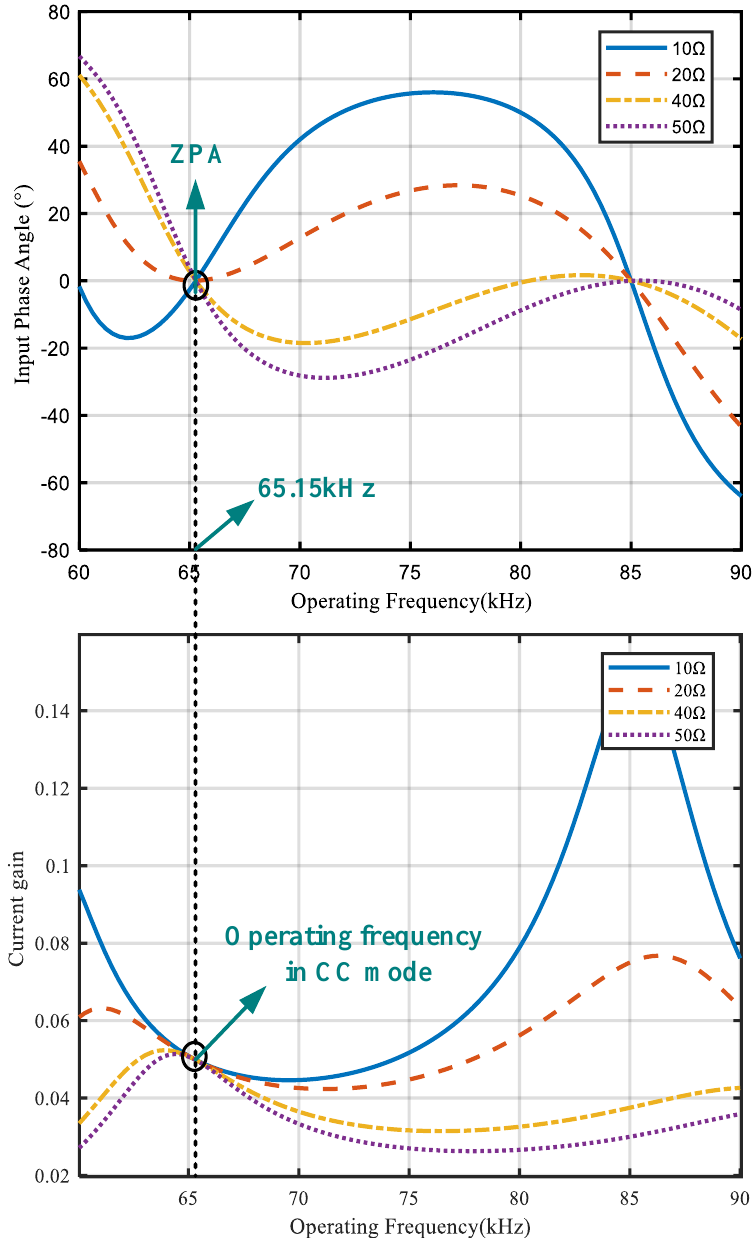
Figure 7. Transconductance gain and phase of input impedance of the S/PS−compensated WPT sys- tem.